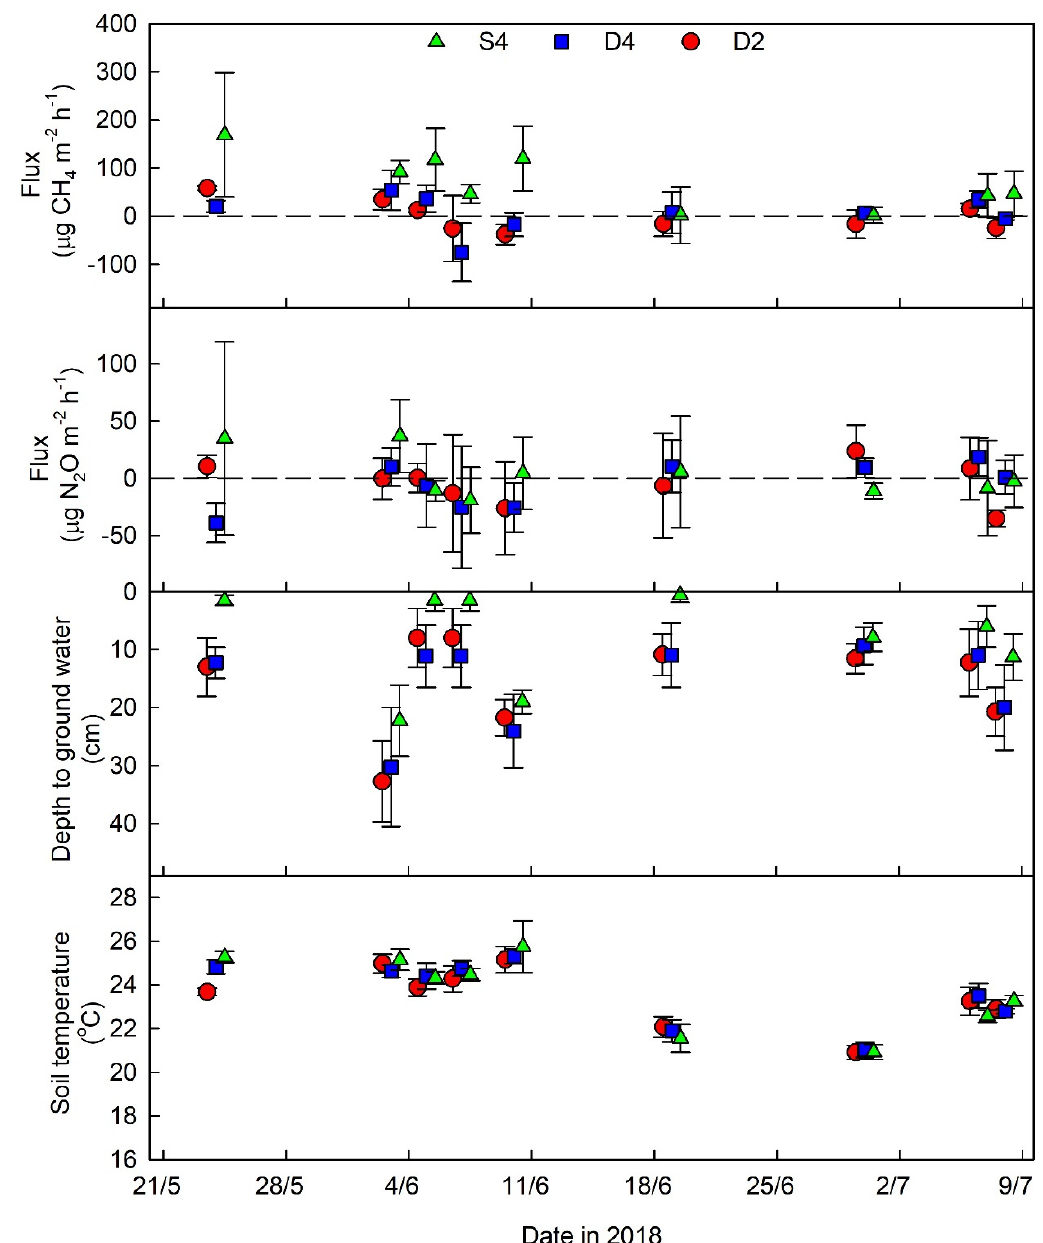
Figure 2. Flux of methane (CH 4 ) and nitrous oxide (N 2 O), groundwater level, and soil temperature in the period May-July 2018 in treatments with: shallow drainage to 0.6 m with weir open four times per week (S4) and deep drainage to 1.2 m, with weir open four times per week (D4) or two times per week (D2). Error bars denote one standard error (n ≤ 4). The flux values represent fluxes from soil-surface including vegetation, negative values indicating uptake of CH 4 or N 2 O.